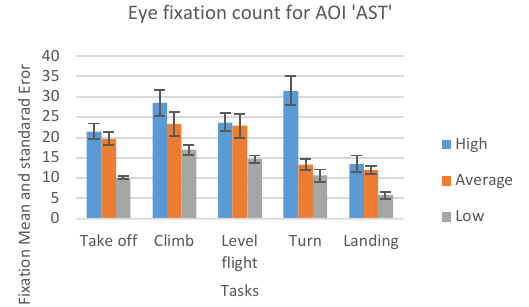
Figure 14. Number of fixations AOI ‘AVST’ for five flight phases for the psychological selection stream with associated Standard